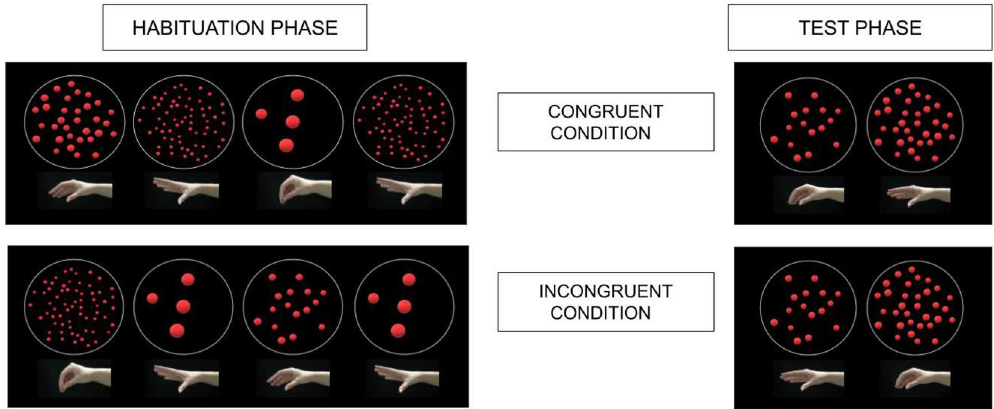
Figure 1. Schema of the habituation and test phases. In the habituation phase infants observed either congruent number-hand pairings or incongruent number-hand pairings. At test, all infants observed an instance of both a congruent and an incongruent pairing using new numerosities and hand openings, with values that were intermediate to those observed during